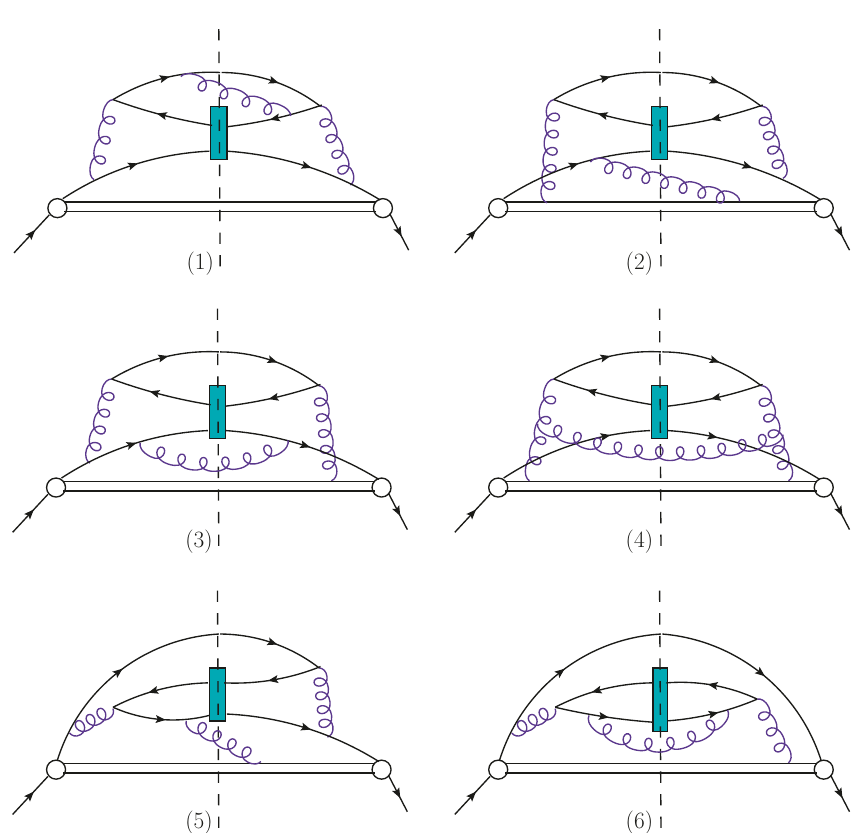
Figure 3 . Six sample cut diagrams for the real corrections to the fragmentation function D Q → ( Q ¯ Q )[ 1 S [1] 0 ]